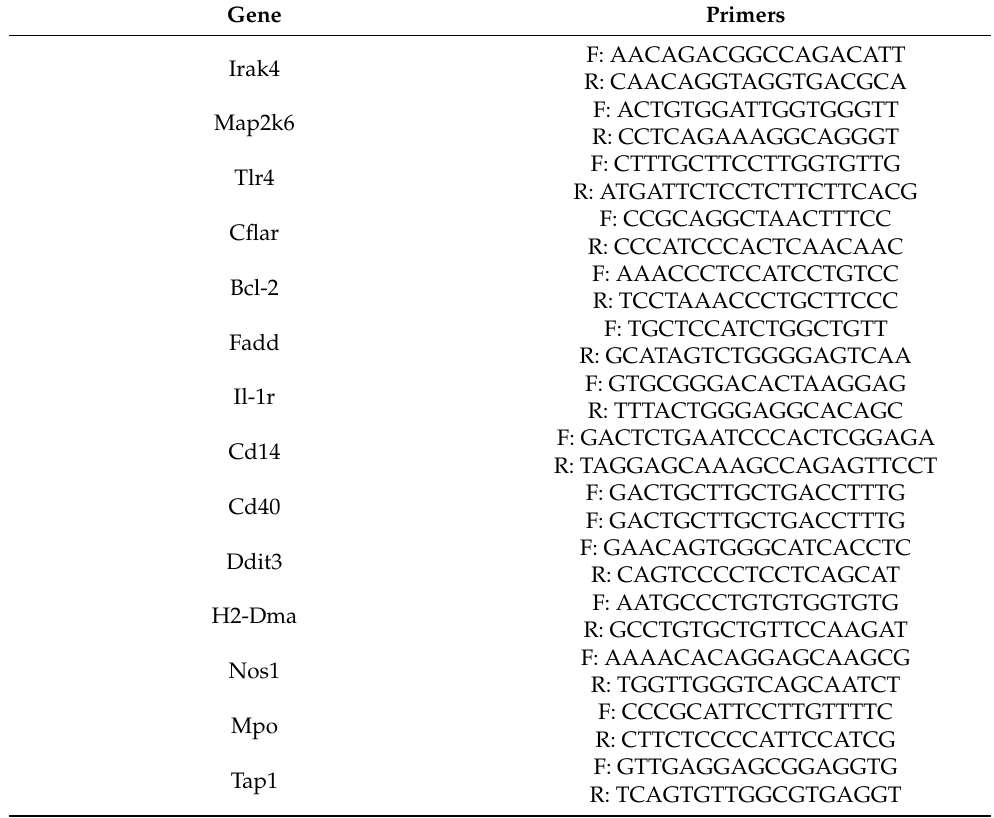
Table 1. The primers for RT-qPCR. Gene